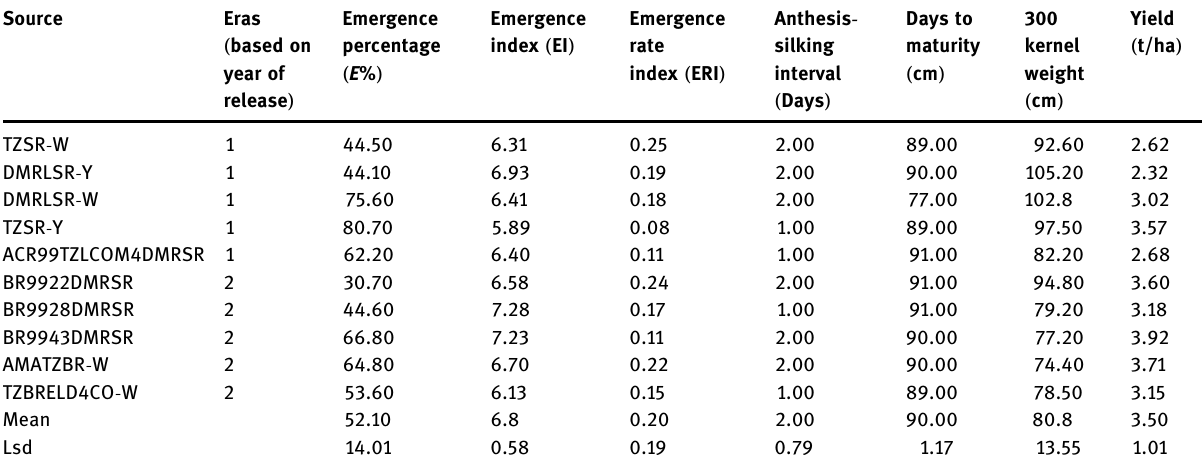
Table 2: Means for location and genotypes for grain yield and agronomic traits in 10 varieties representing two maize breeding eras in Nigeria evaluated at Orin and Iropora, 2008 and 2009